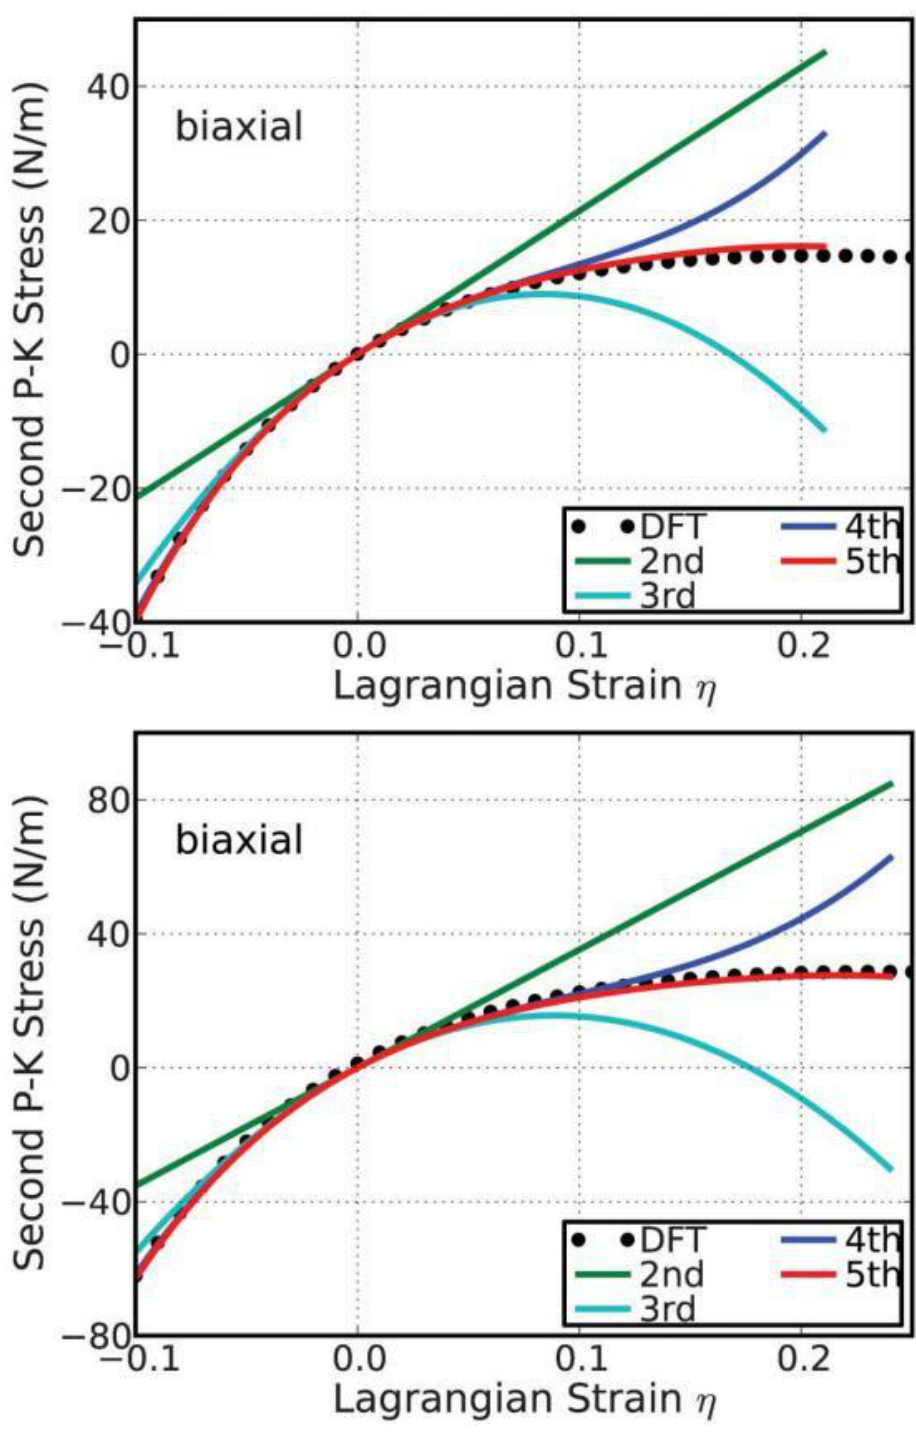
Figure 11. Predicted stress–strain responses from different orders: second, third, fourth, and fifth order, and compared to the DFT calculations in the biaxial deformation of g-AlN ( top ) and g-BN ( bottom ).